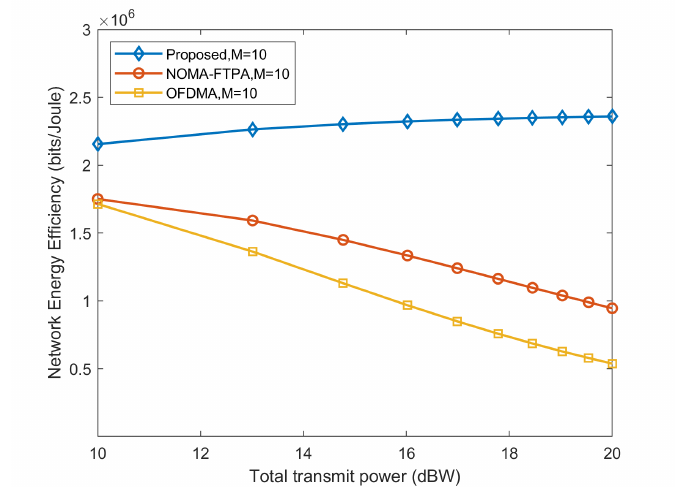
Figure 3. Network energy efficiency performance for different transmit power of cell.